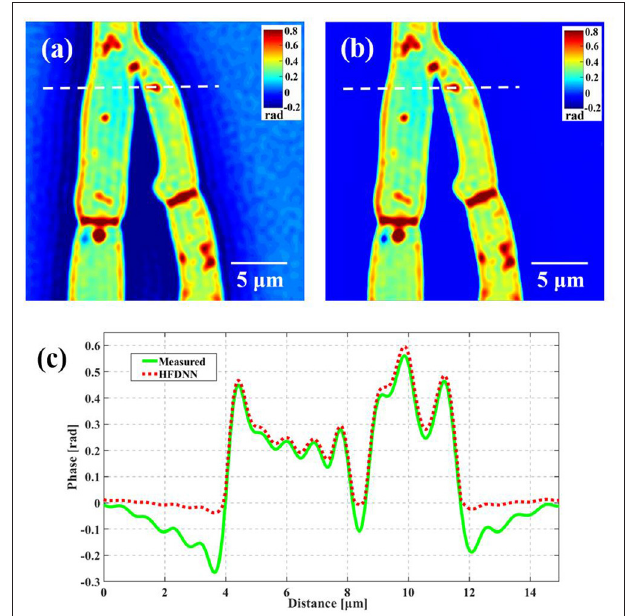
FIGURE 7 | The reconstructed results of the spores in monascus. (a) The measured image; (b) the reconstructed image by the HFDNN without re-training; (c) the phase profiles along the same position drawn in (a,b) ; the green curve illustrates the profile of the measured data; the red dash curve illustrates the profile of the HFDNN.